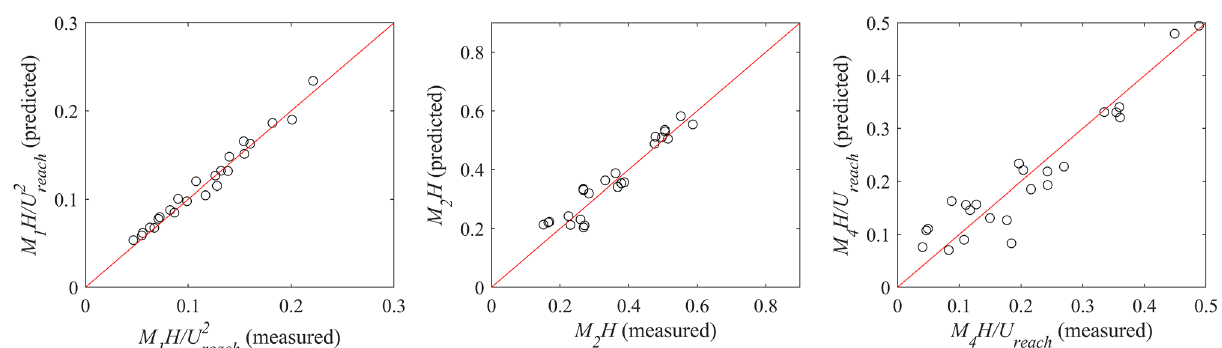
Figure 8. The predicted dimensionless habitat hydraulic complexity parameters from the proposed equations against the measured values from the experiments. M 1 is the kinetic energy gradient metric, M 2 is the normalized kinetic energy gradient metric, and M 4 is the modified recirculation metric. H is reach-averaged flow depth, and U reach is reach-averaged flow velocity. The red line shows R 2 =